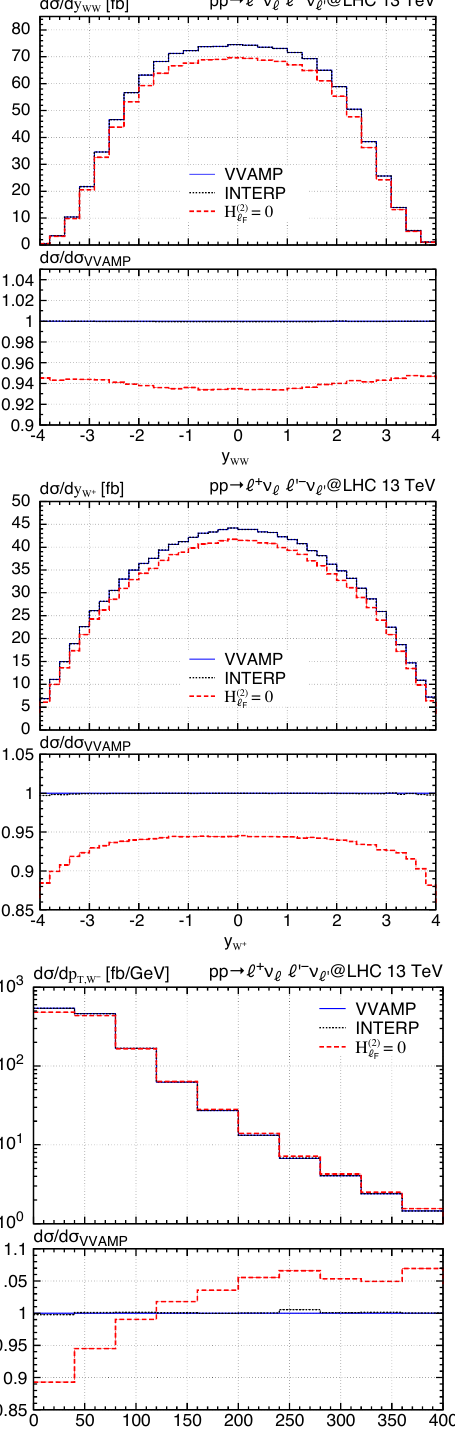
Figure 6. Powheg stage 2 distributions (from left to right and top to bottom) in y y , m exp , p and p for the VVAMP (blue, solid line), the interpolator (black, dotted line) T,miss T, WW W + T, W (cid:0) and the H (2) = 0 (red, dotted line) ‘ F